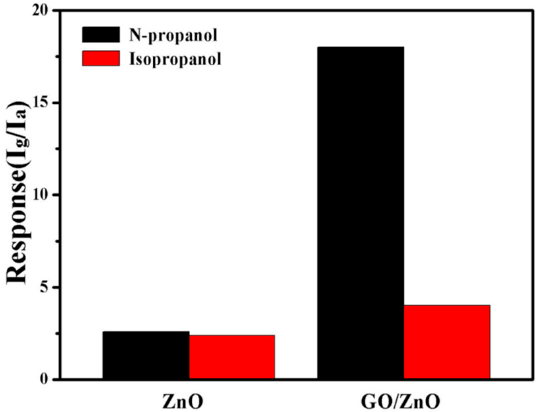
Figure 11. Response sensitivity of the porous ZnO nanosheets and GO/ZnO nanosheet composites